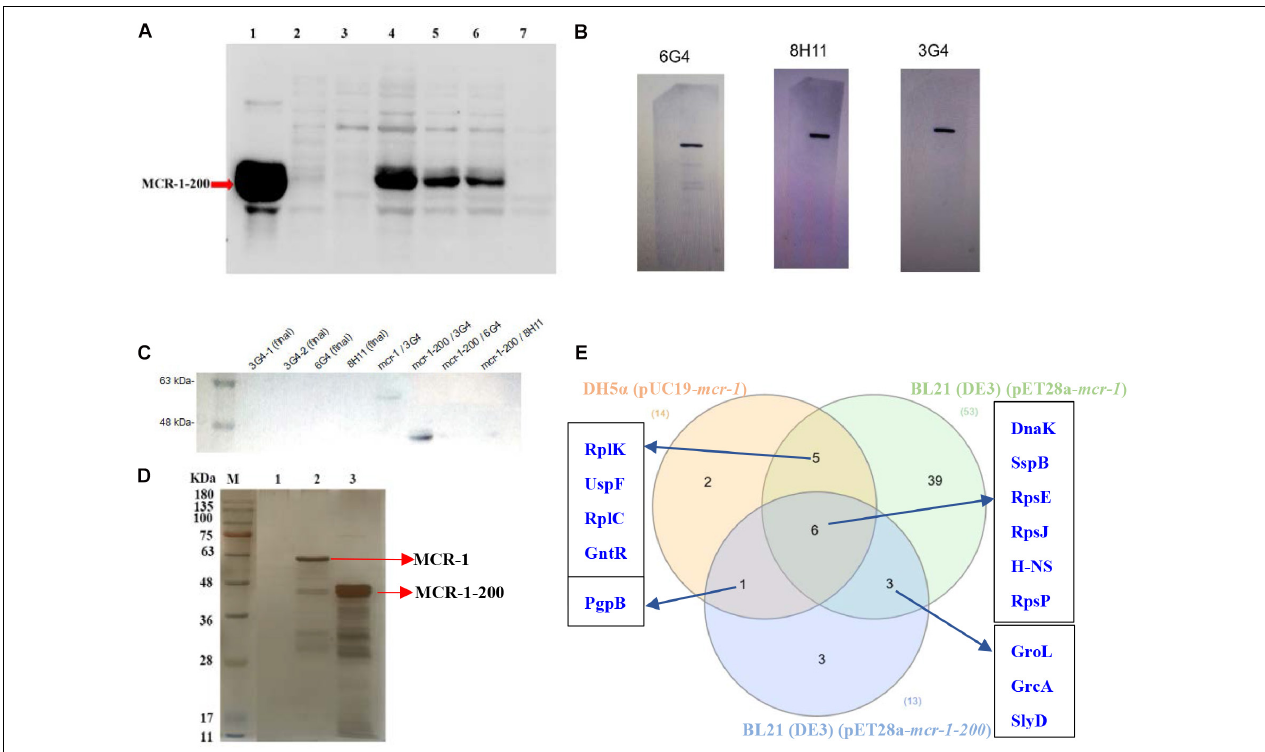
FIGURE 1 | Characterization of the developed Co-IP assays. (A) MCR-1 catalytic domain expression in cell lysate. Lane 1–3: purified protein eluted from Ni-NTA column by the elution buffer, wash buffer, and binding buffer, respectively; Lane 4–5: total cellular protein in supernatant and pellets of the sonicated cell lysates, respectively; Lane 6–7: total cellular protein induced expression with IPTG and total cellular protein without induction, respectively. (B) Anti-MCR-1 mAbs validation using the cell lysate through regular Western blot method. (C) Comparison of the prepared anti-MCR-1 mAbs in Co-IP. (D) Representative silver-stained SDS-gel of the eluted binding proteins mixtures using 3G4 mAb bait. M: prestained protein ladder 11–180 KDa; Lanes 1–3: E. coli BL21 (DE3) (pET28a), BL21 (DE3) (pET28a- mcr-1 ), and BL21 (DE3) (pET28a- mcr-1-200 ), respectively. (E) The Venn diagrams of the identified MCR-1 interacting proteins in three different E. coli